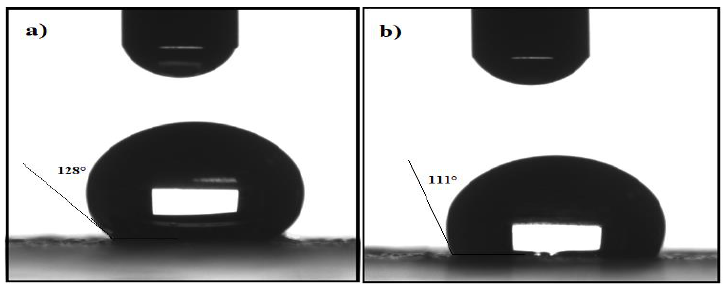
Figure 7. Contact angles of water on magnetite nanomaterials coated by a ) M. aurea extract (MAE-MNMs) and b ) O. baccatus extract (OBE-MNMs).